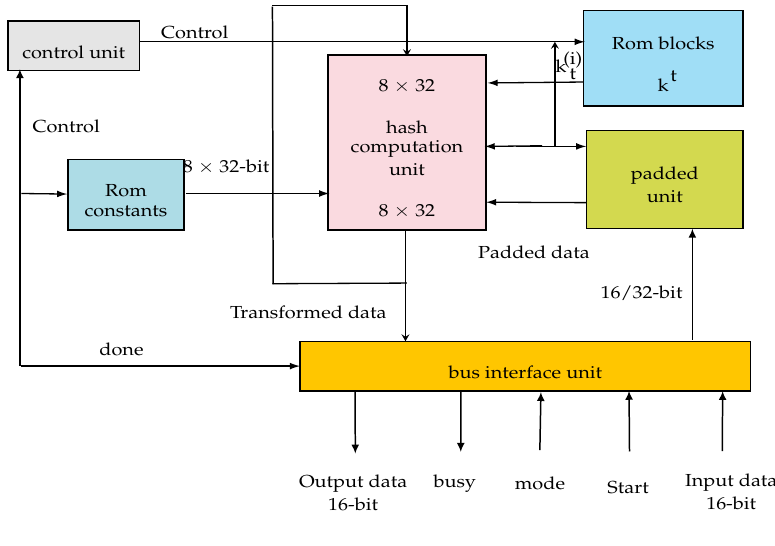
Figure 2. The proposed SHA-2